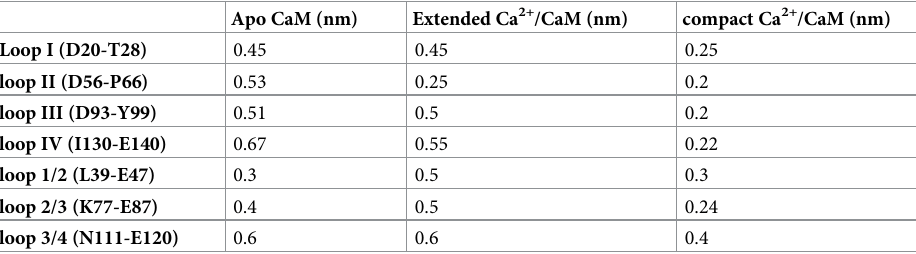
Table 2. RMSD of different loops of Ca 2+ binding region of